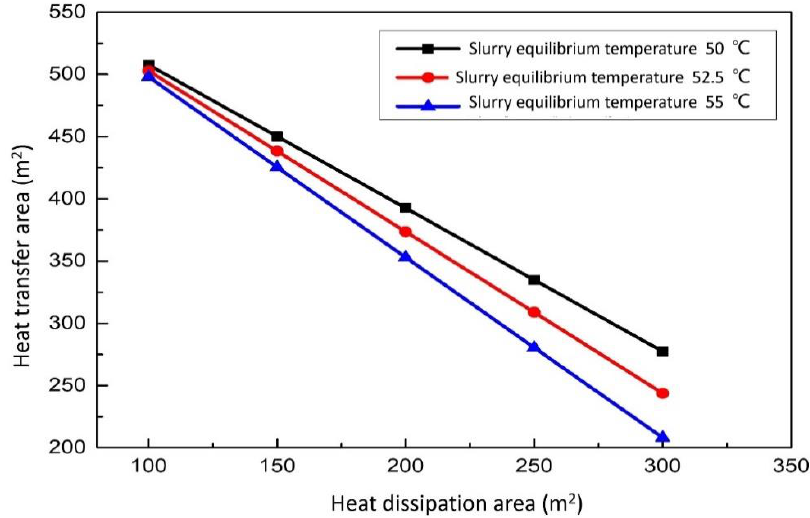
Figure 11. Effect of heat dissipation area on the heat transfer area.